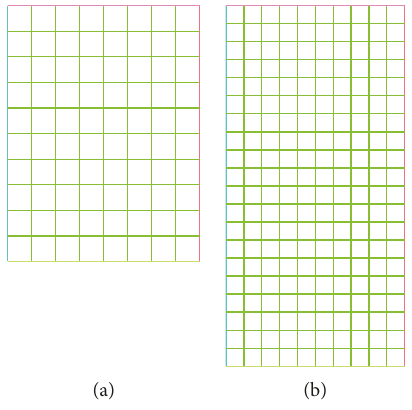
Figure 6: Meshing of different sections. (a) 150 mm